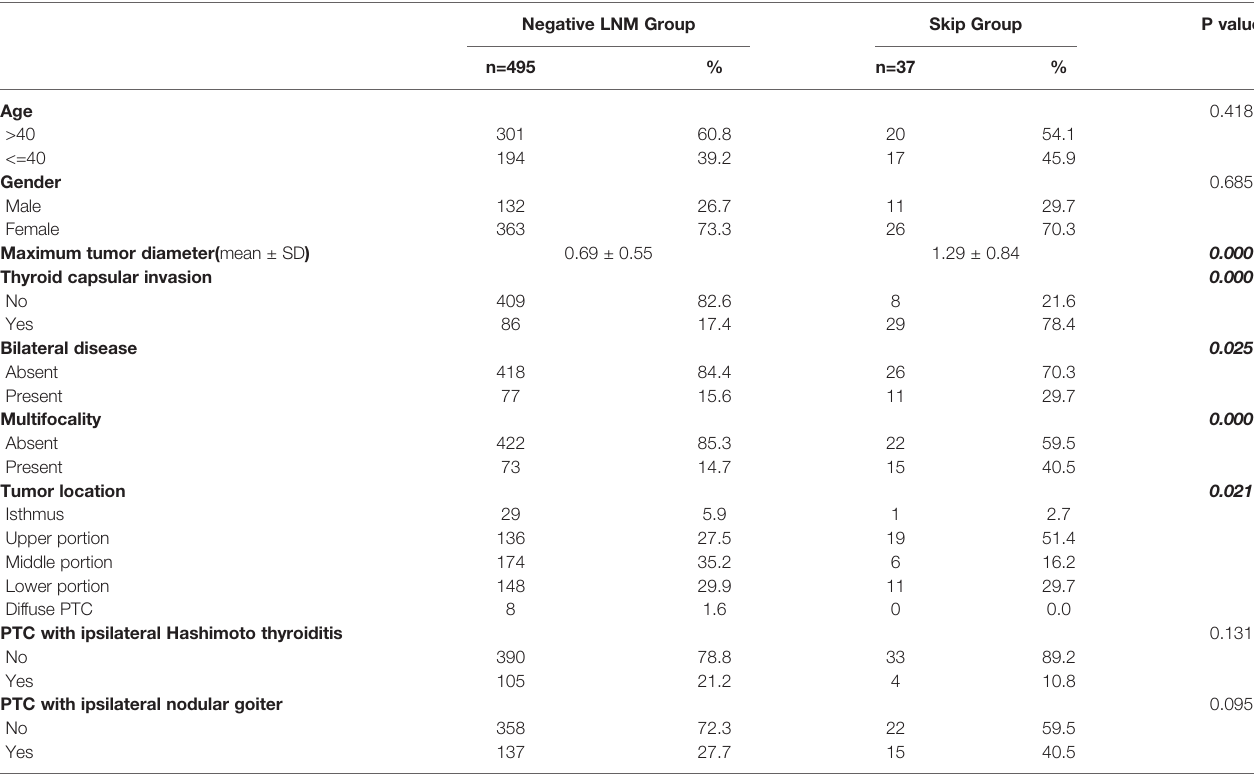
TABLE 3 | The clinicopathological characteristics of PTC patients with no